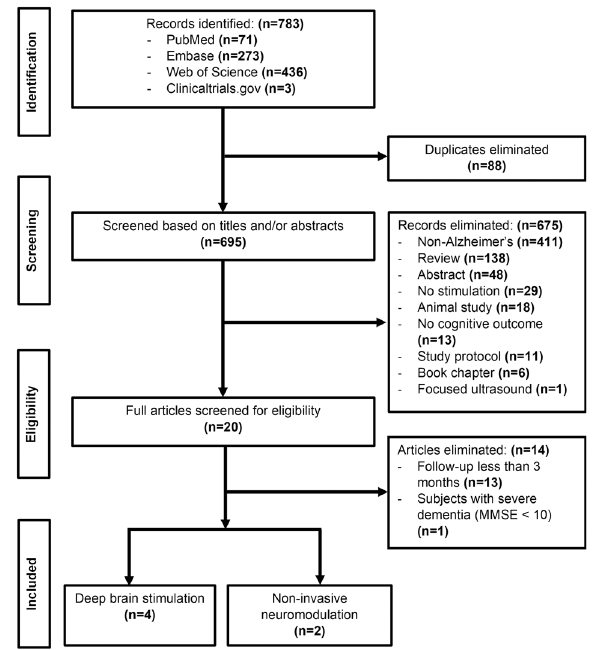
Fig. 1 PRISMA fl ow diagram. MMSE, mini-mental state